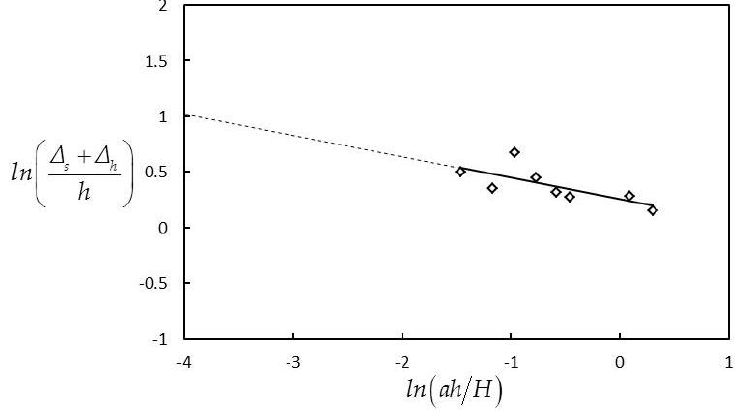
Figure 6. Influence depth ∆ s + ∆ h varies with the comprehensive parameter ah/H . Figure 6. Influence d epth Δ s + Δ h varies with the comprehensive parameter ah/H .